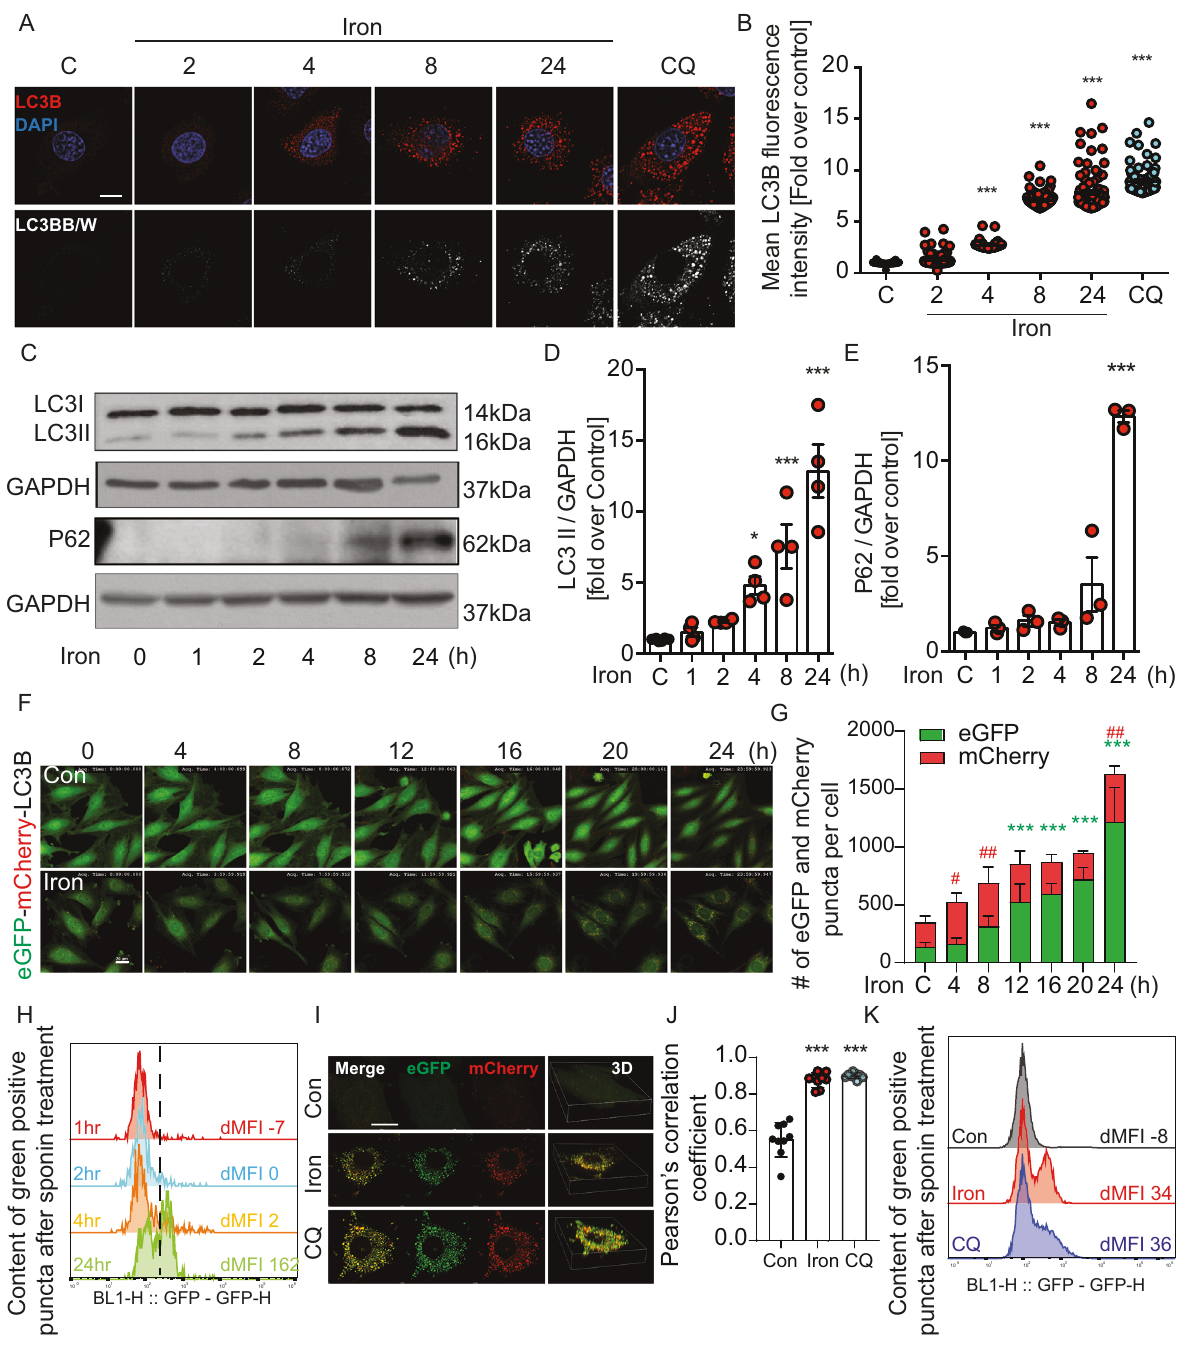
Fig. 4 Examination on iron-induced alterations in autophagy fl ux. Representative immuno fl uorescent images detecting LC3B in response to 250 µM FeCl 3 , at 2, 4, 8, 24 h or CQ (30 µM, 24 h) and quanti fi cation of their mean fl uorescent intensity A , B ( n = 3). Representative western blotting images of LC3B and P62 C , and quantitation relative to GAPDH D , E after 250 µM FeCl 3 for 1, 2, 4, 8, 24 h ( n = 4). Representative confocal microscopy time lapse image of L6 cells stably expressing tandem fl uorescent eGFP-mCherry-LC3B after treatment with 250 µM FeCl 3 F . Quanti fi cation of eGFP-mCherry-LC3B puncta G ( n = 3). eGFP fl uorescence was measured by fl ow cytometry in L6 cells stably expressing tandem fl uorescent eGFP-mCherry-LC3B treated with with 250 μ M FeCl 3 for 1, 2, 4 or 24 h after saponin permeabilization and cytoplasmic washout of the cells. eGFP dMFIs were quanti fi ed by subtracting the MFI of WT L6 cells from that of eGFP-mCherry-LC3B cells H ( n = 3). Representative confocal image of L6 cells stably expressing tandem fl uorescent eGFP-mCherry-LC3B after treatment FeCl 3 (250 μ M, 24 h) or CQ (30 µM, 24 h) I , Pearson ’ s correlation coef fi cient J , fl ow cytometer K ( n = 3). Scale bar denotes 20 µm. All graphs show mean ± SEM and * = P < 0.05, ** = P < 0.01, *** = P < 0.001 versus control, # = P < 0.05, ## = P < 0.01, ### = P < 0.001 versus